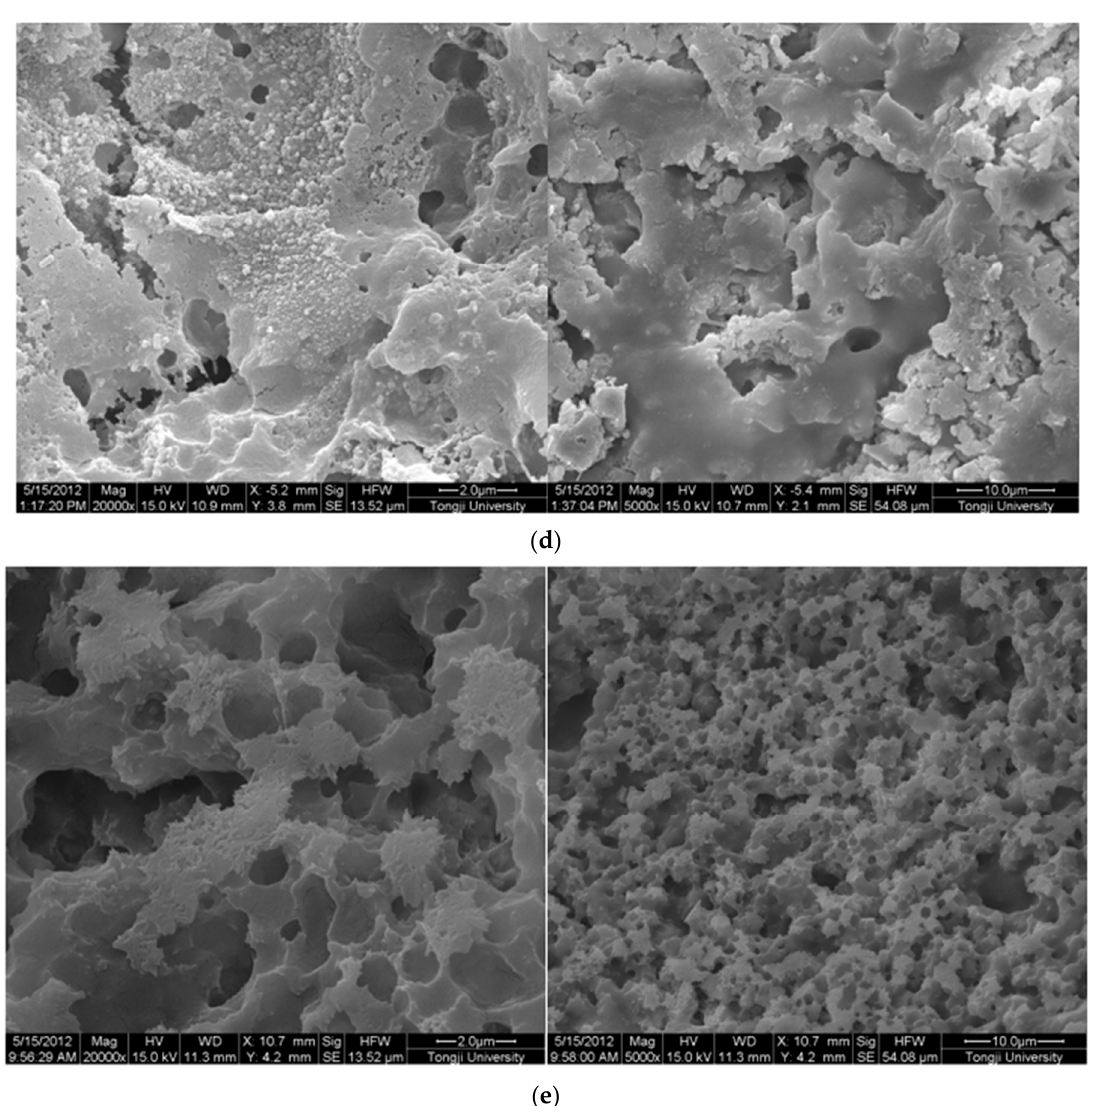
Figure 3. Morphology of 0.3 w/c cement paste and EVA-modified cement pastes with different EVA latex/cement ratios at 28 days. ( a ) 0.3 w/c cement paste, ( b ) m p /m c = 4%, ( c ) m p /m c = 8%, ( d ) m p /m c = 12%, ( e ) m p /m c = 16%. ( d ) m p /m c = 12%, ( e ) m p /m c =